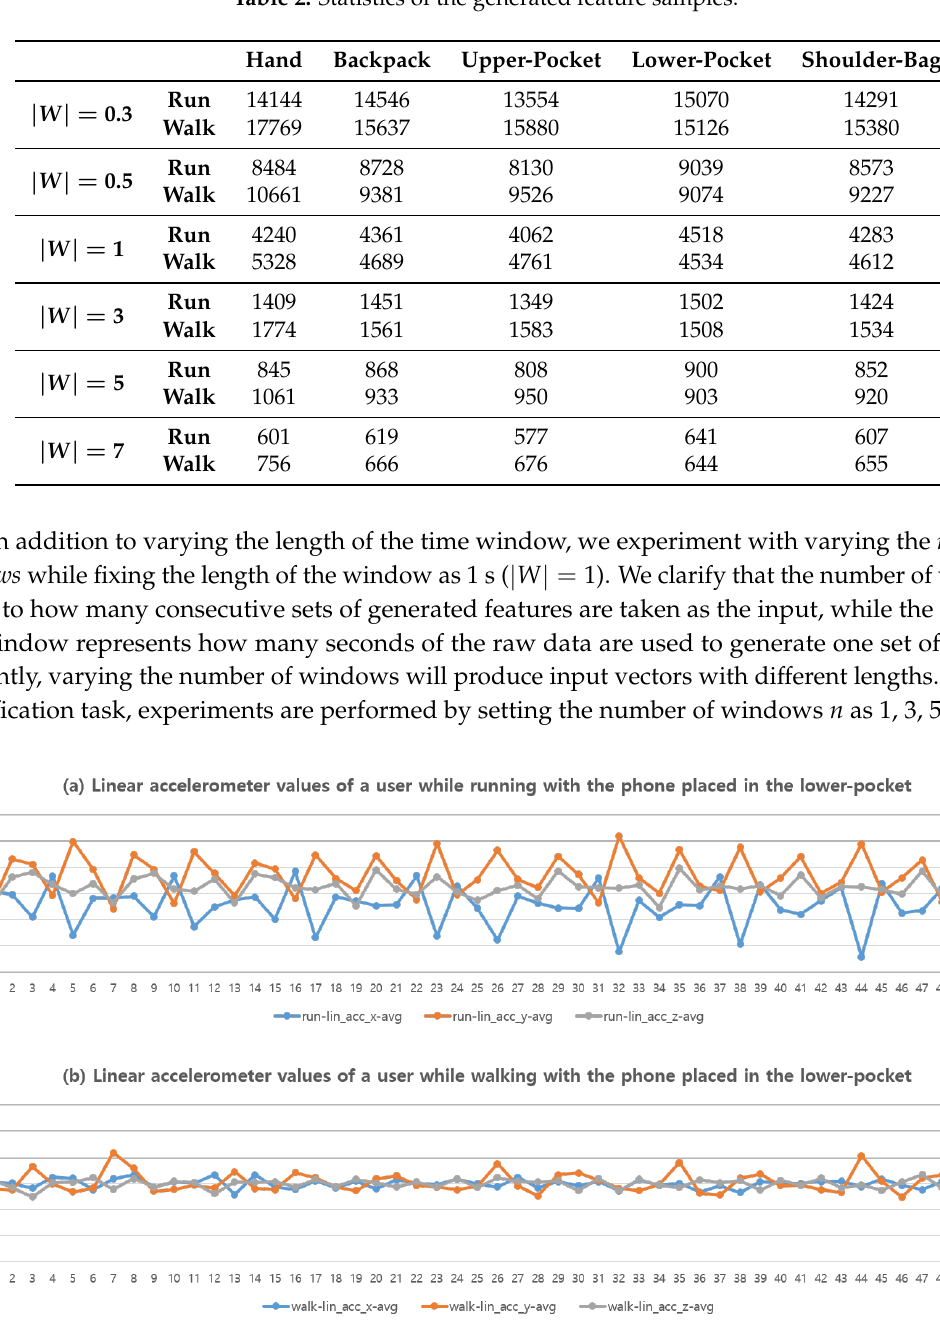
Table 2. Statistics of the generated feature samples.